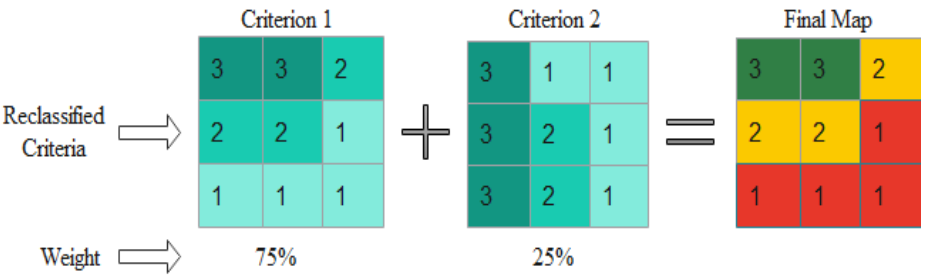
Figure 3. A schematic example of the final map generation weight overlay method.